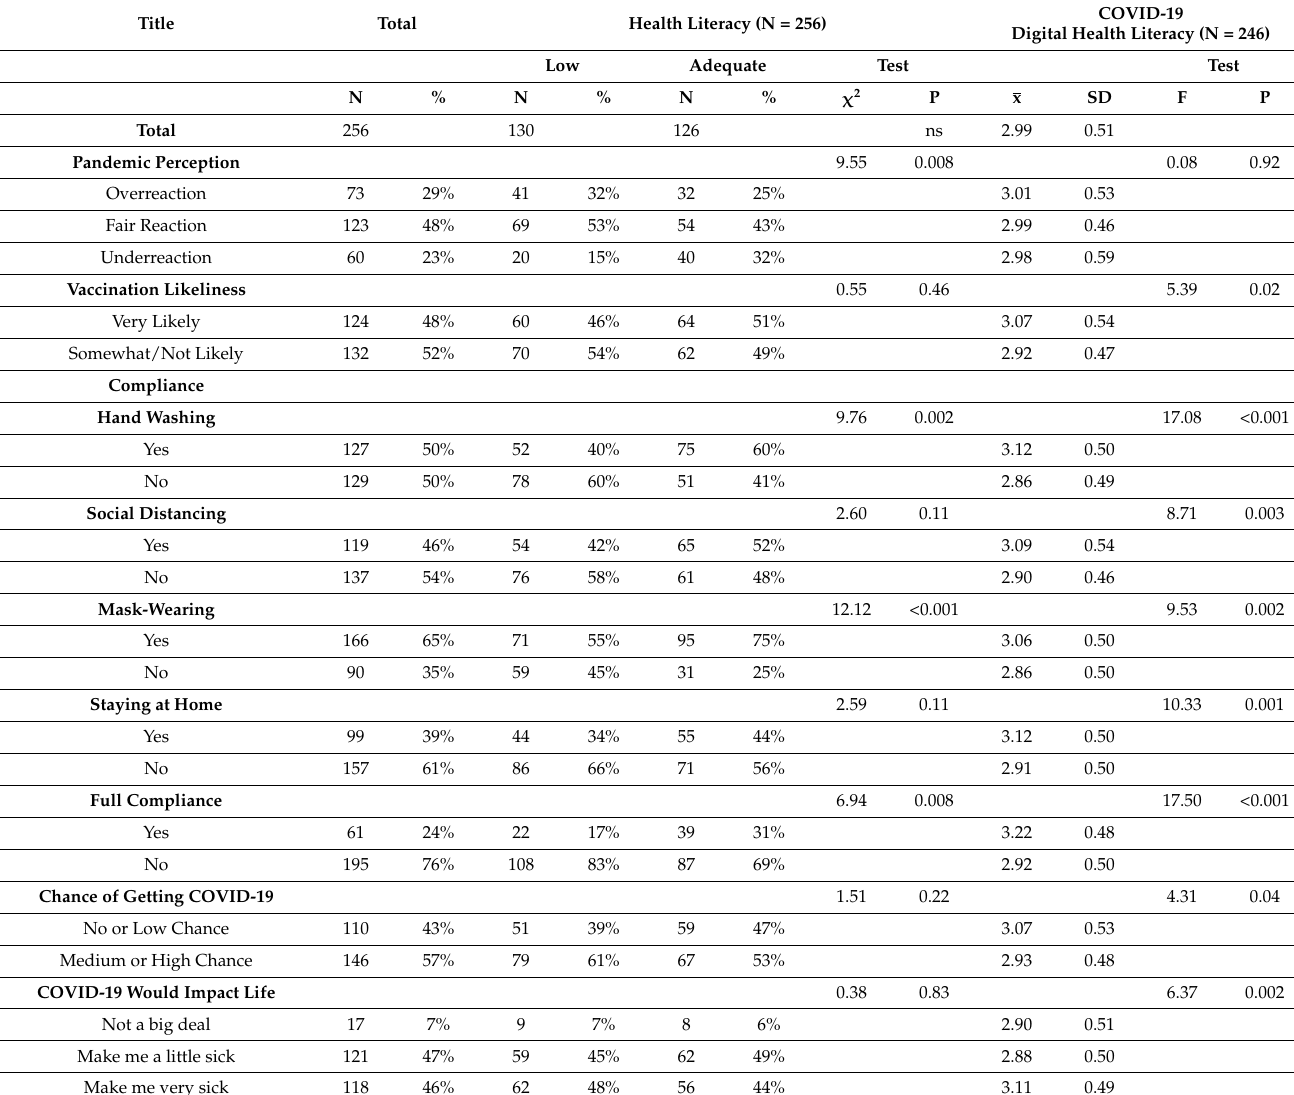
Table 2. Pandemic responses by health literacy and COVID-19 digital health